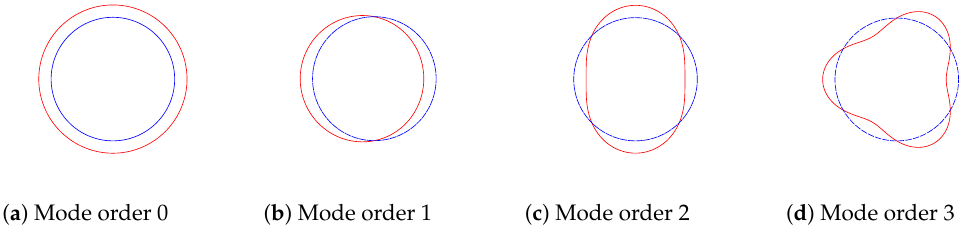
Figure 7. Lowest four mode orders. The deformed mode shape is indicated in red and the unde- formed mode shape in blue.